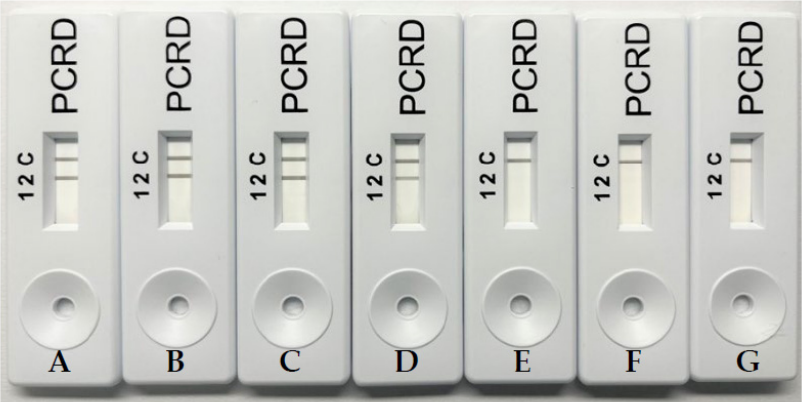
Figure 4. Sensitivity test of porcine DNA by RPA with NALFIA; (( A ) 10, ( B ) 1, ( C ) 0.1, ( D ) 0.01, ( E ) 0.001, and ( F ) 0.0001) ng/ µ L with no template control ( G ).